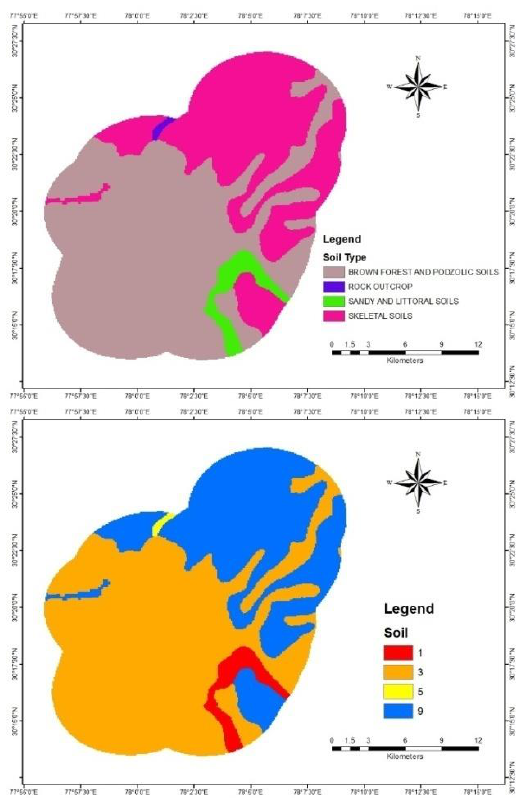
Figure 3. Soil type Suitability Map